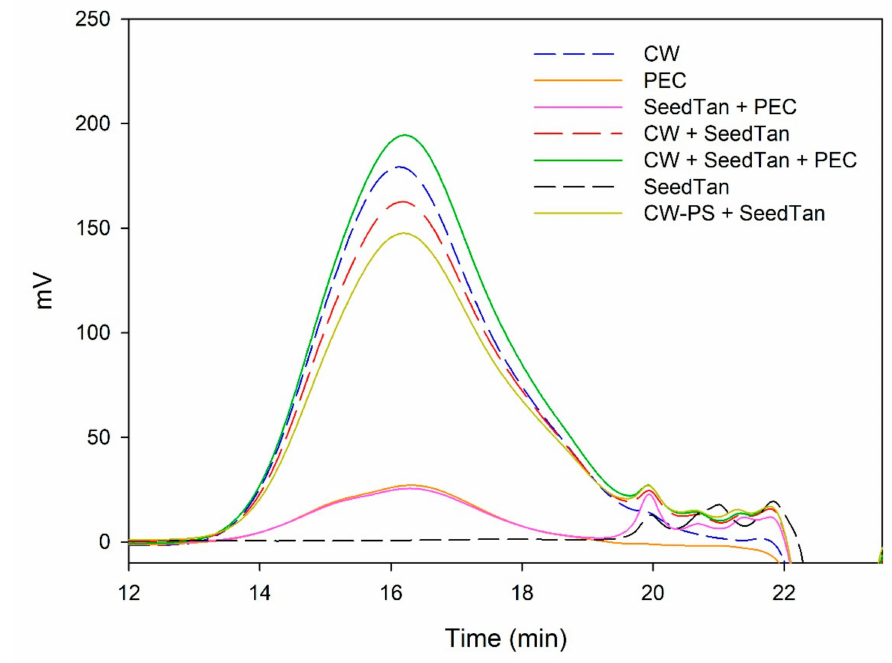
Figure 7. Analysis of the mass distribution of polysaccharides by SEC. Comparison of the polysaccharides released in the interaction tests between SeedTan, PEC, CW, and